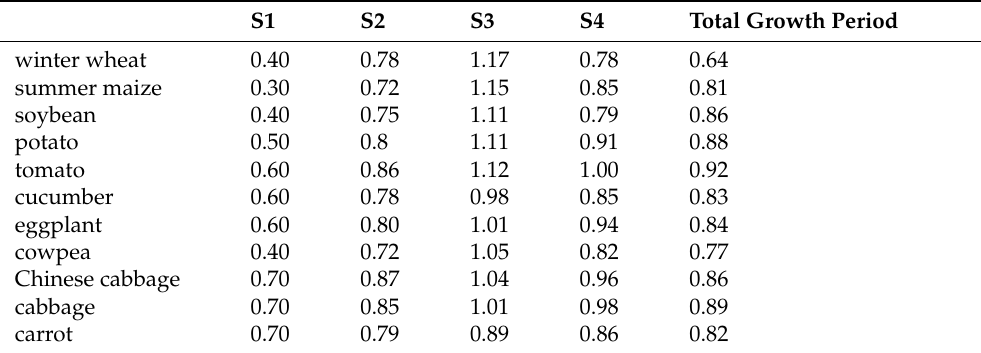
Table 1. K c values of major grain and vegetable